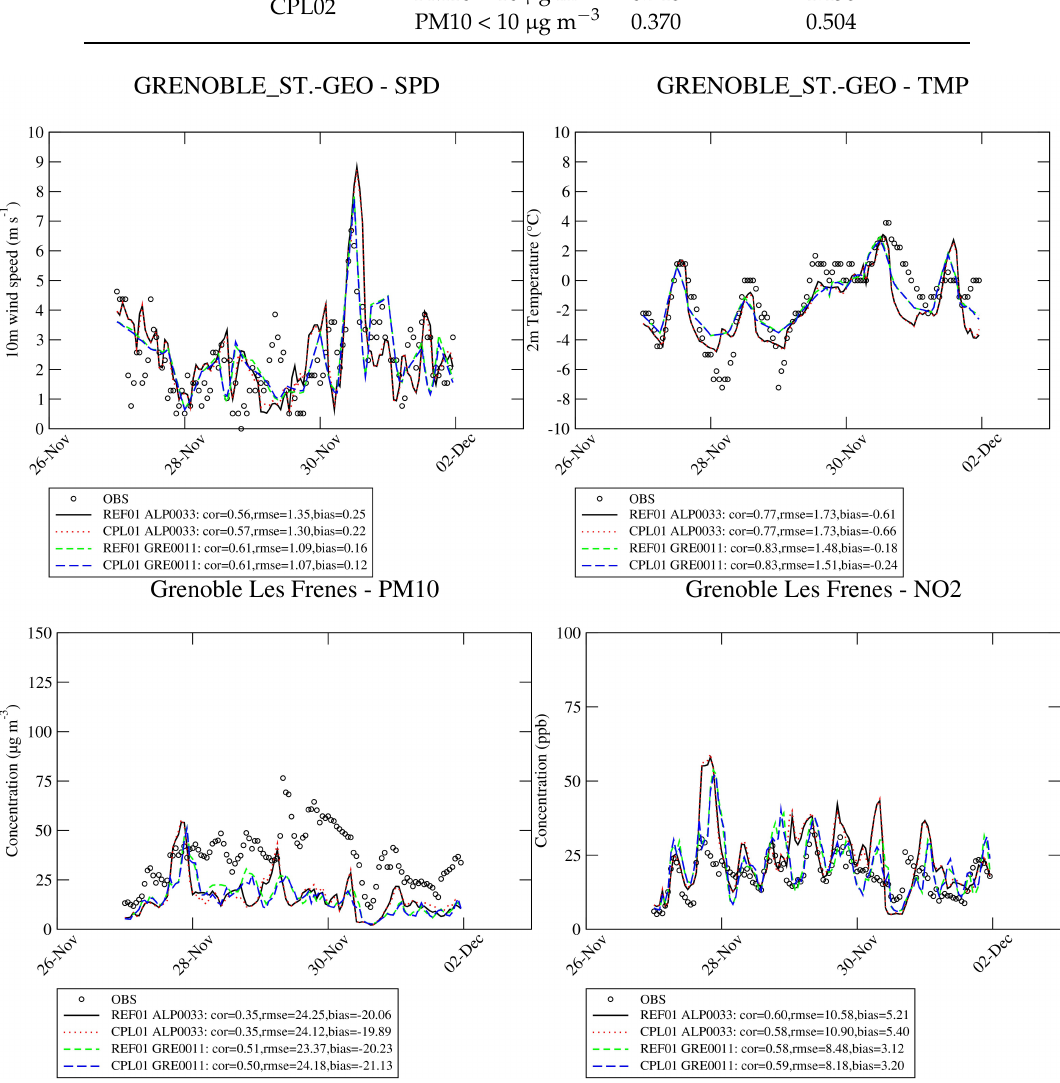
Figure 6. Impact of the on-line coupling on meteorological variables (temperature and wind speed) and hourly PM10 and NO 2 concentrations over Grenoble for two resolutions 1 ⁄ 30 ◦ (ALP0033) and 1 ⁄ 90 ◦ (GRE0011) from 27 November to 01